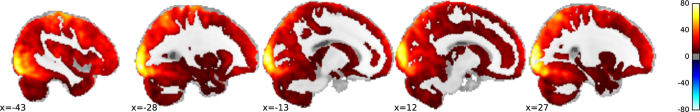
Group-level F-map, at a threshold of p<0.05 Bonferroni-corrected, representing the total area of the brain significantly covered by all tasks featuring the first release of the IBC dataset (FFX across tasks and subjects).One can readily see that all the brain is covered, with higher values in sensory cortices and weaker values for the temporal and pre-frontal cortex as well as subcortical structures.